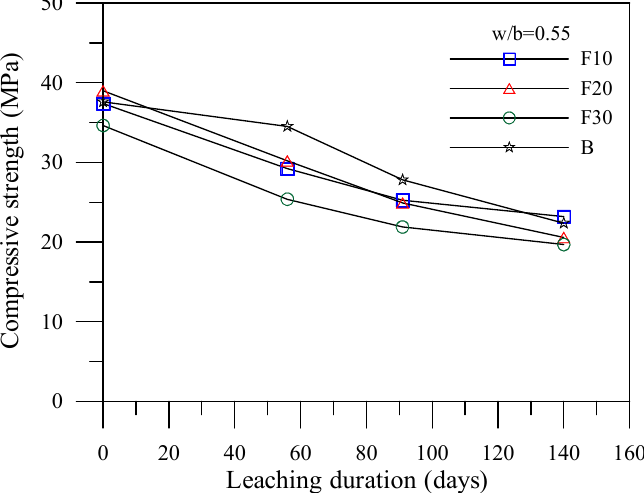
Figure 4. Compressive strength vs. leaching duration for the specimens with fly ash.